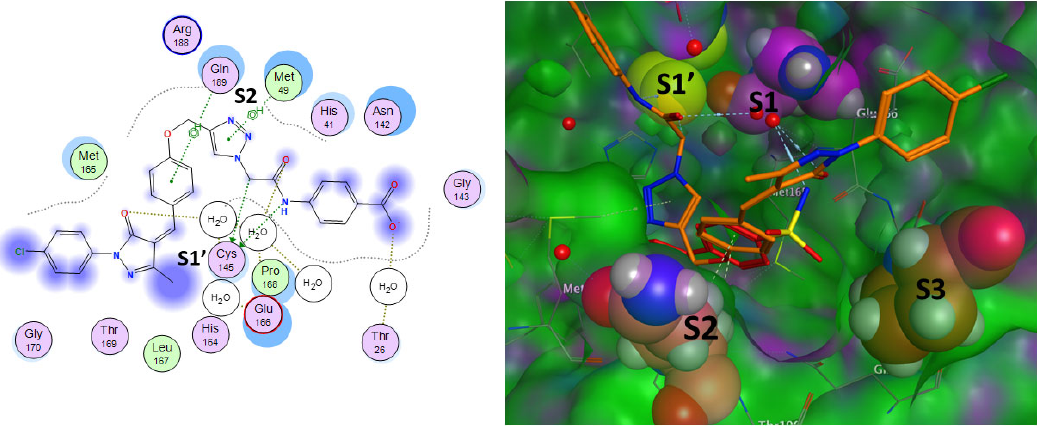
Figure 7. Docked poses of main protease (PDB ID: 5R80) complexed with Z18197050 and 6i compound with 2D interaction map for 6i (right) and 3D interaction map of both aligned compounds (left). The catalytic sites are presented in bold black as S1, S1 ′ , S2, and S3 subsites. Fill-space models of active site residues were presented. In 2D part, the interactions were presented in dotted-colored lines.